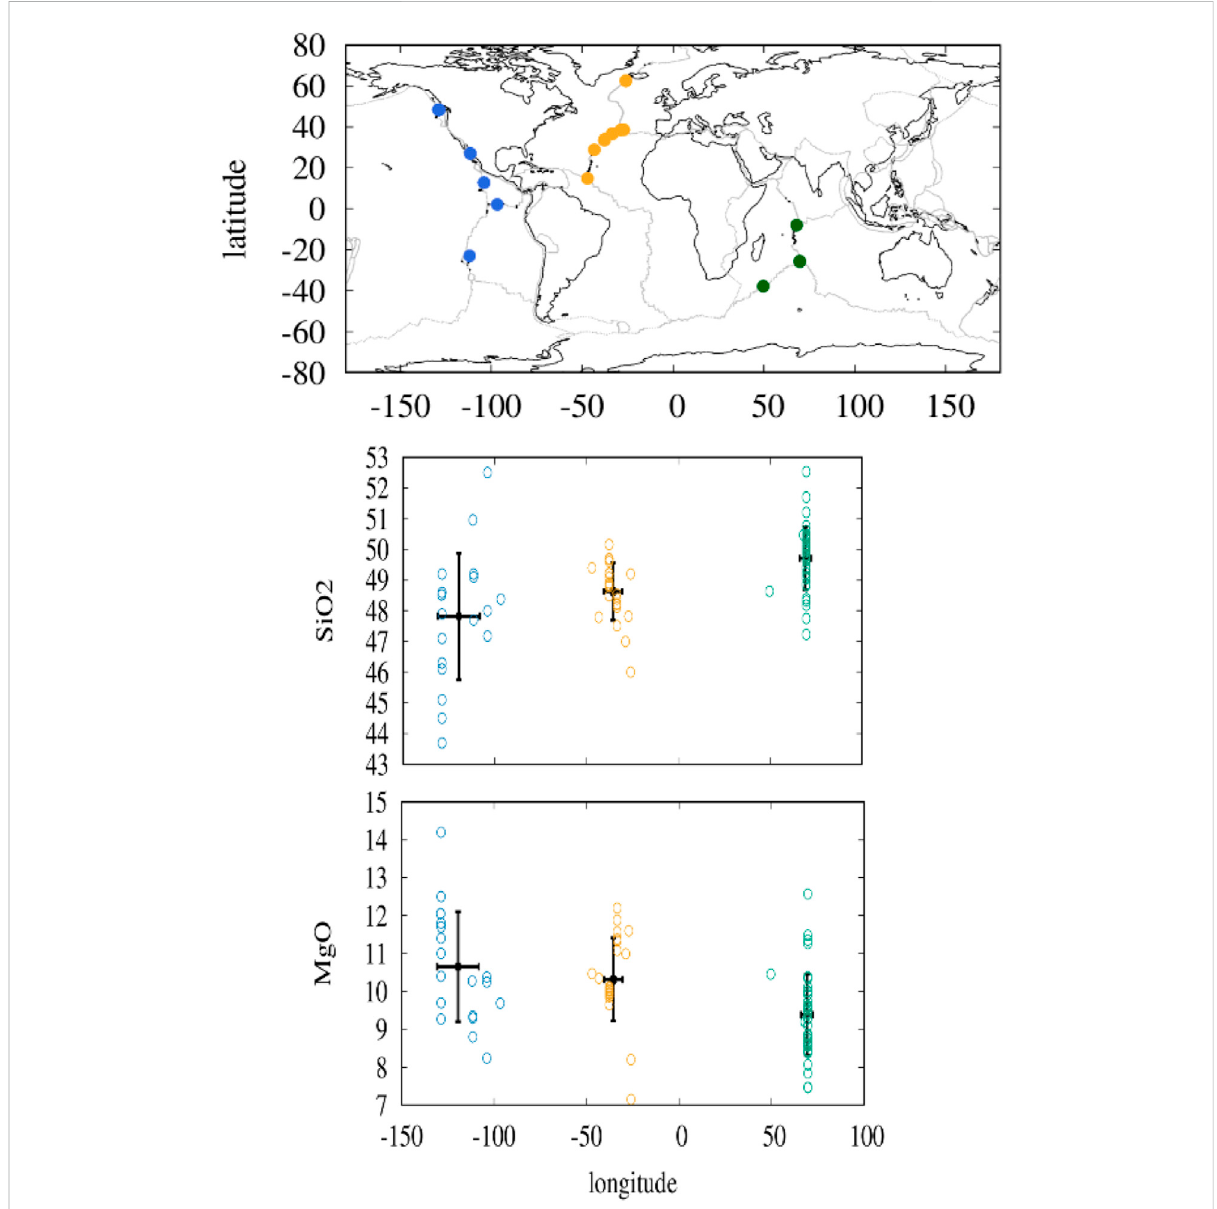
FIGURE 10 Distribution and compositions of relatively undifferentiated mid-ocean ridge basalts in the Paci fi c, Atlantic, and Indian Oceans. The basalt data areselectedfromtheopendatabasePetDB[https://www.earthchem.org/,Lehnertetal.,2000]dataforFeO*/MgOratiolessthanunity,whereFeO* indicates total iron as FeO. The SiO 2 and MgO wt% are plotted as a function of